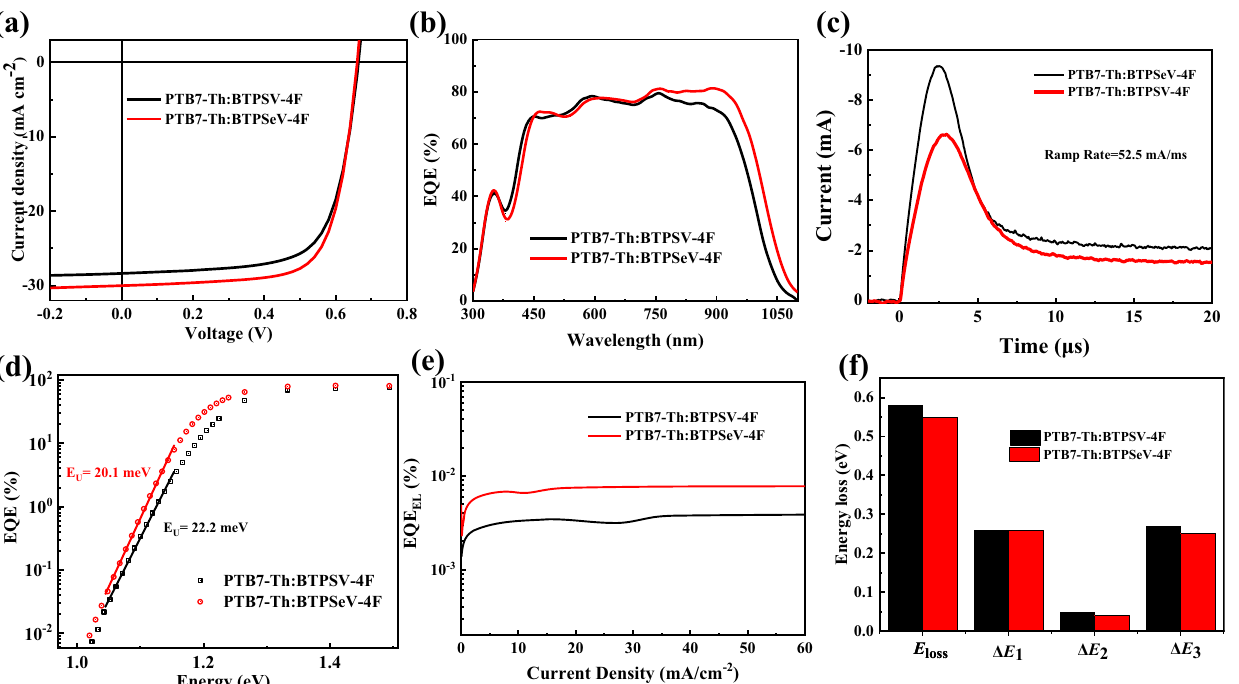
Fig. 2 | Photovoltaic performance of ultra-narrow bandgap acceptors. a J − V curves of the optimized OSCs based on PTB7-Th:BTPSV-4F and PTB7-Th:BTPSeV- 4F, under the illumination of AM1.5G, 100mWcm − 2 . Source data are provided as a Source Data fi le. b The external quantum ef fi ciency (EQE) spectra of the corre- sponding OSCs. Source data are provided as a Source Data fi le. c The Photo-CELIV